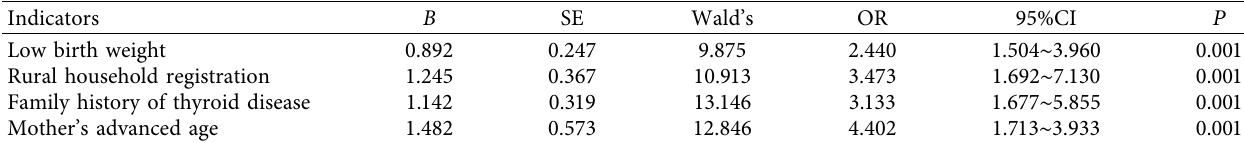
Table 4: Multifactorial analysis of morbidity in children with